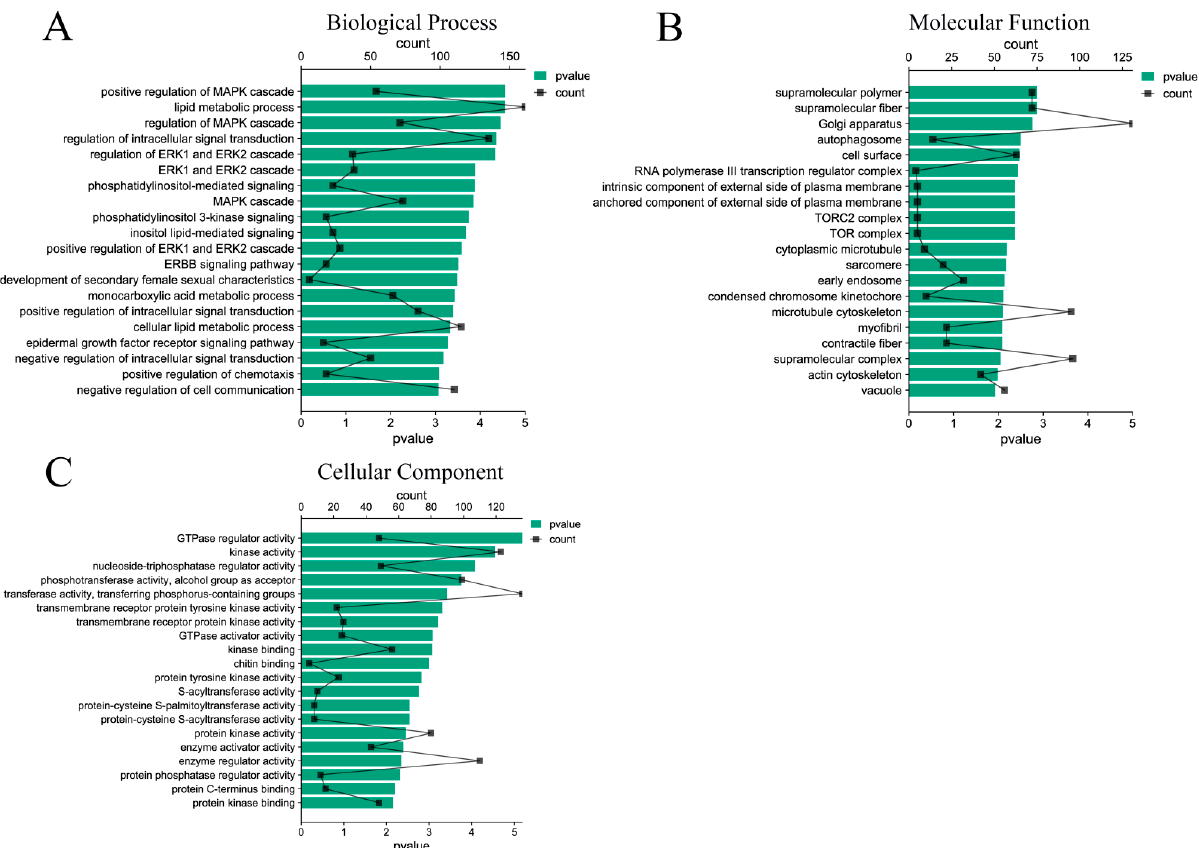
Figure 3. Differential expression of miRNAs in exosomes. ( A ) Volcano plot of miRNAs between control and treatment groups; ( B ) hierarchical clustering heatmap of DE miRNAs between control and treatment groups.